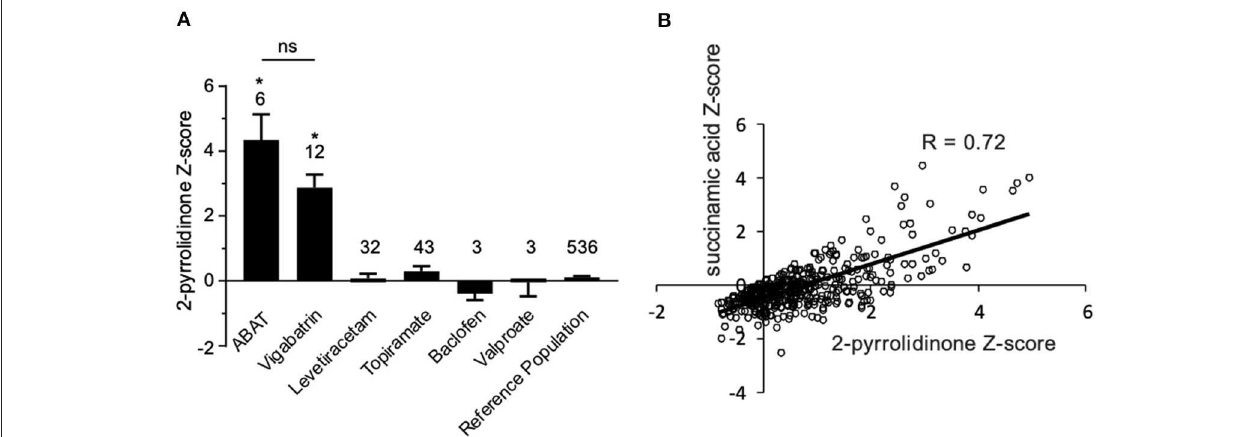
FIGURE 4 | Box plot profile for 2-pyrrolidinone levels detected in plasma for all clinical samples. (A) Z -scores for all clinical EDTA plasma samples are plotted using a box plot format. ABAT cases show elevated Z -scores for 2-pyrrolidinone versus those patients without GABA-transaminase deficiency and treated with vigabatrin, topiramate, and/or valproate. If patients were receiving vigabatrin in addition to other treatments, they were grouped with vigabatrin. Bars represent the mean + /– the standard error of the mean (SEM) of the Z -scores for 2-pyrrolidinone for each group. The numbers above the bars represent the number of unique patient samples for each group. * p < 0.05. NS indicates a comparison which was not statically significant, p > 0.05. (B) Correlation of 2-pyrolidinone levels to succinamic acid levels in clinical plasma samples. Samples which had both 2-pyrrolidinone and succinamic acid Z -scored ( n = 409) are plotted showing a significant positive correlation with these two molecules. TABLE 1 | Clinical demographics of patients diagnosed with GABA-transaminase deficiency. Patient Sample ID